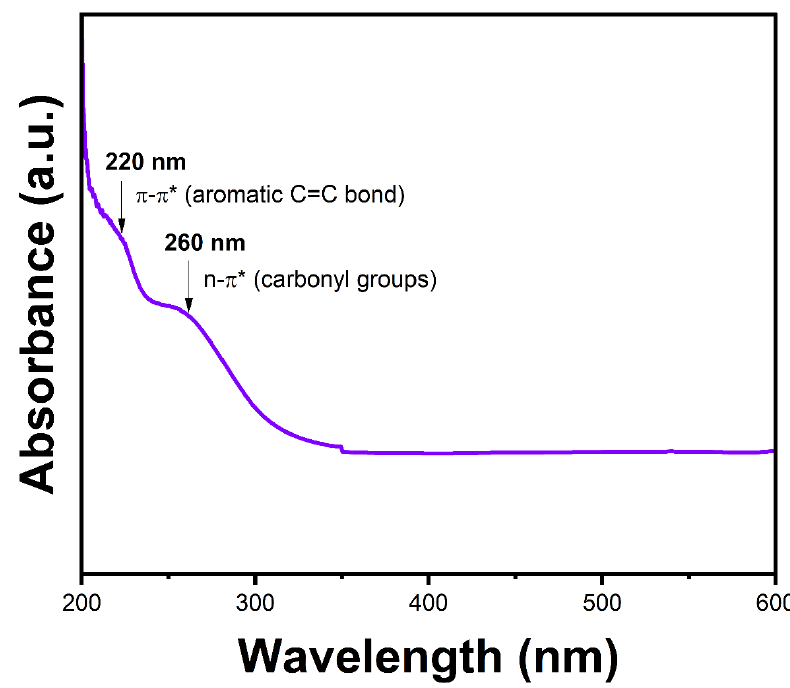
Figure 1. UV-vis spectrum of GO.